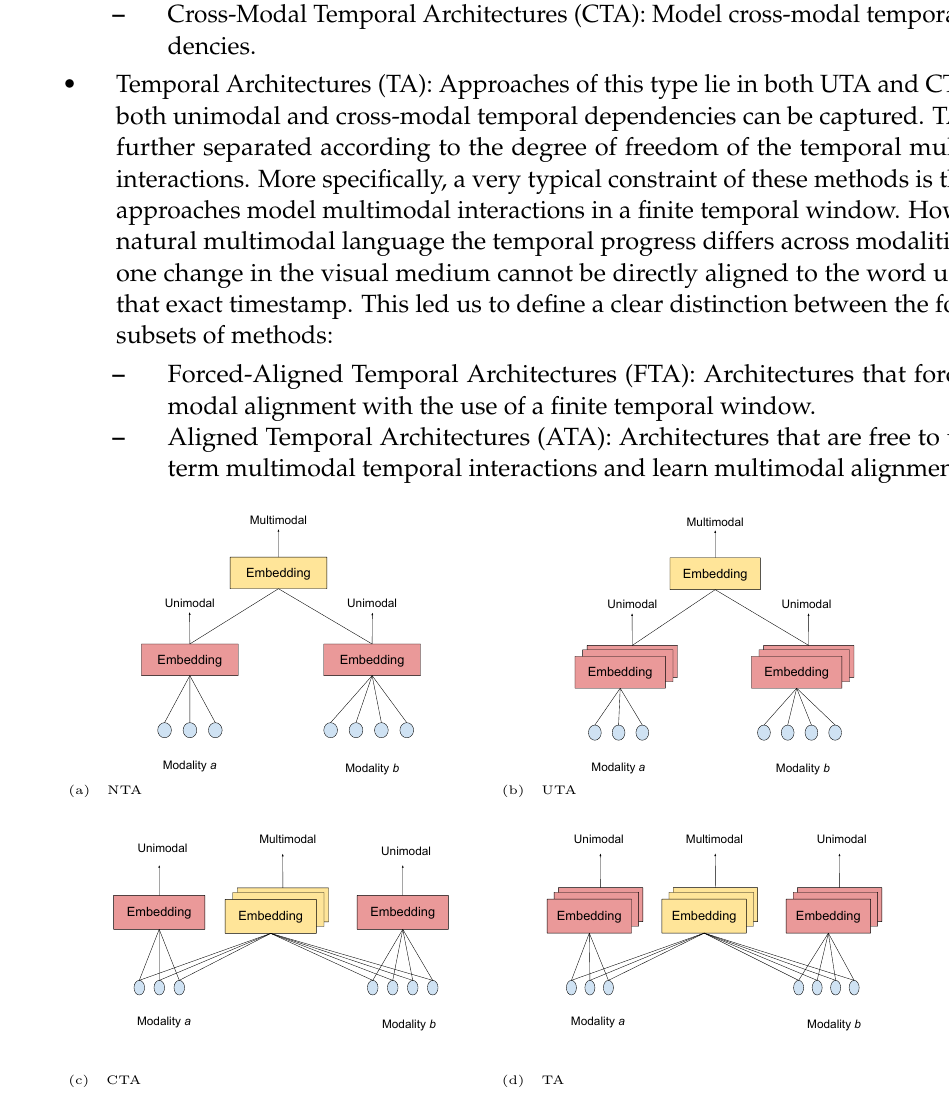
Figure 1. Deep temporal multimodal architectures categorization based on temporal learning prop- erties. Parallel rectangles indicate that the learning process is performed on a temporal sequence of feature vectors, while standalone rectangles are used when learning is performed on a static— probably statistical—feature vector of predefined dimensions that represents the whole temporal sequence. The four listed categories are ( a ) NTA: Non-Temporal Architectures, ( b ) UTA: Unimodal Temporal Architectures, ( c ) CTA: Cross-Modal Temporal Architectures and ( d ) TA: Temporal Archi- tectures. In ( a , b ) the multimodal representation is based on static vector representations, while in ( c , d ) it is calculated using the initial temporal sequence of each